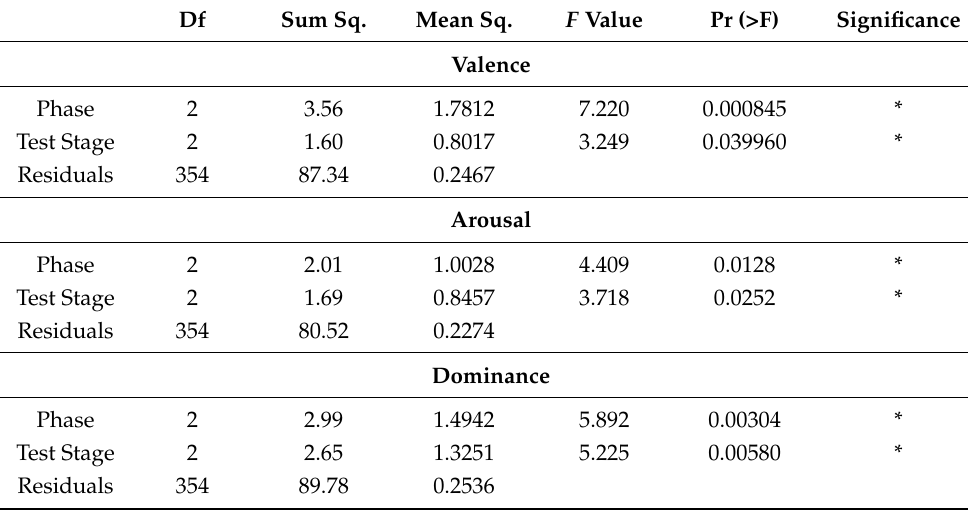
Table 5. Results extracted from a Multifactorial Additive ANOVA. Df Sum Sq. Mean Sq.